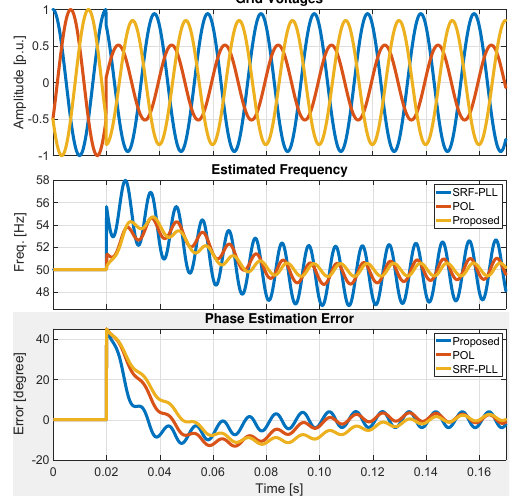
Figure 7. Comparative numerical simulation results for Test-IV: Unbalance